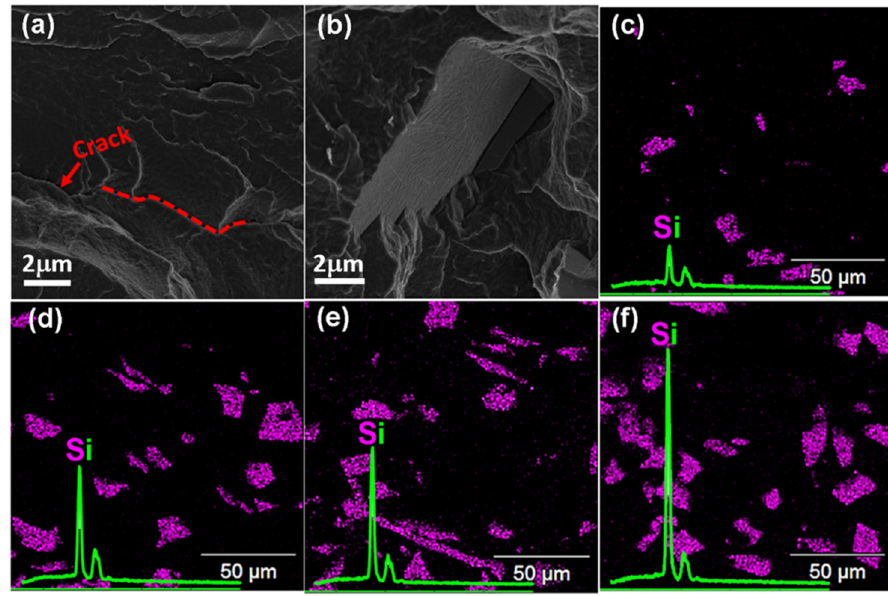
Figure 1. Cross sectional SEM micrographs of the freeze-fractured composites: ( a ) neat polybutylene succinate (PBS) and ( b ) PBS-40. ( c – f ) EDXS mapping of the Si atom in the composites: ( c ) PBS-10, ( d ) PBS-20, ( e ) PBS-30, and ( f ) PBS-40.